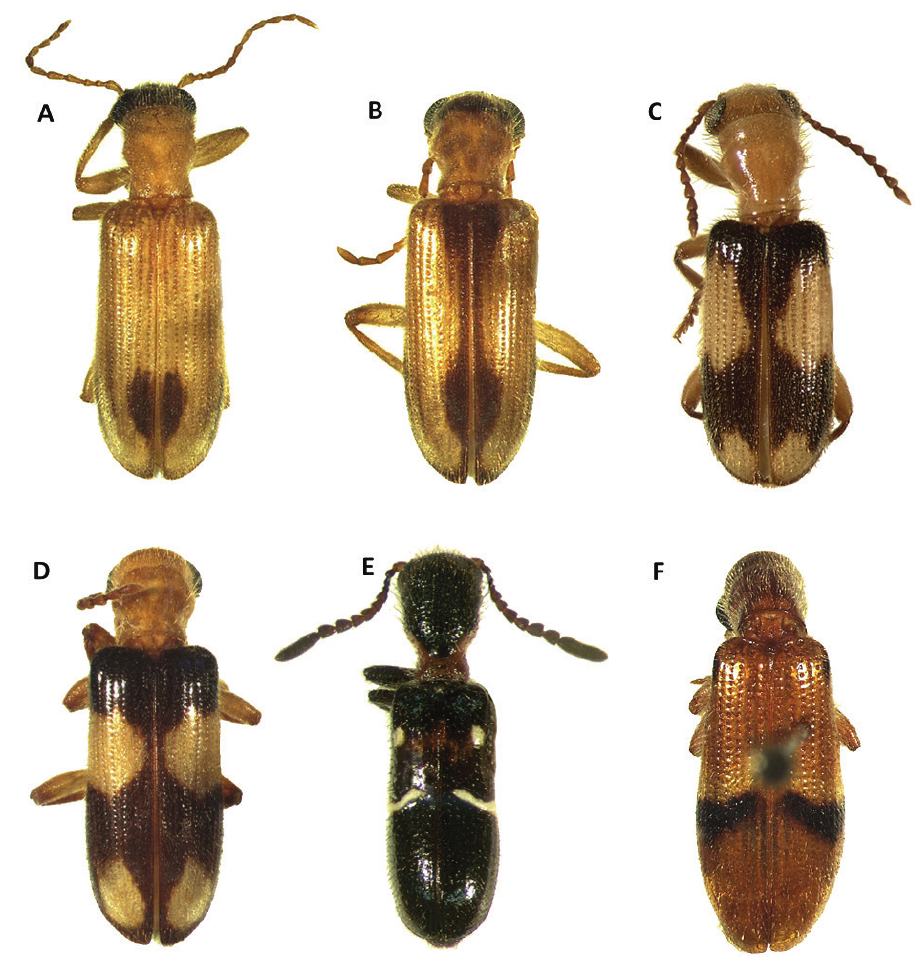
Figure 1. Habitus of: A Araeodontia isabellae B Araeodontia marginalis C Araeodontia peninsularis D Araeodontia picta E Barrotillus kropotkini F Bogcia disjuncta .